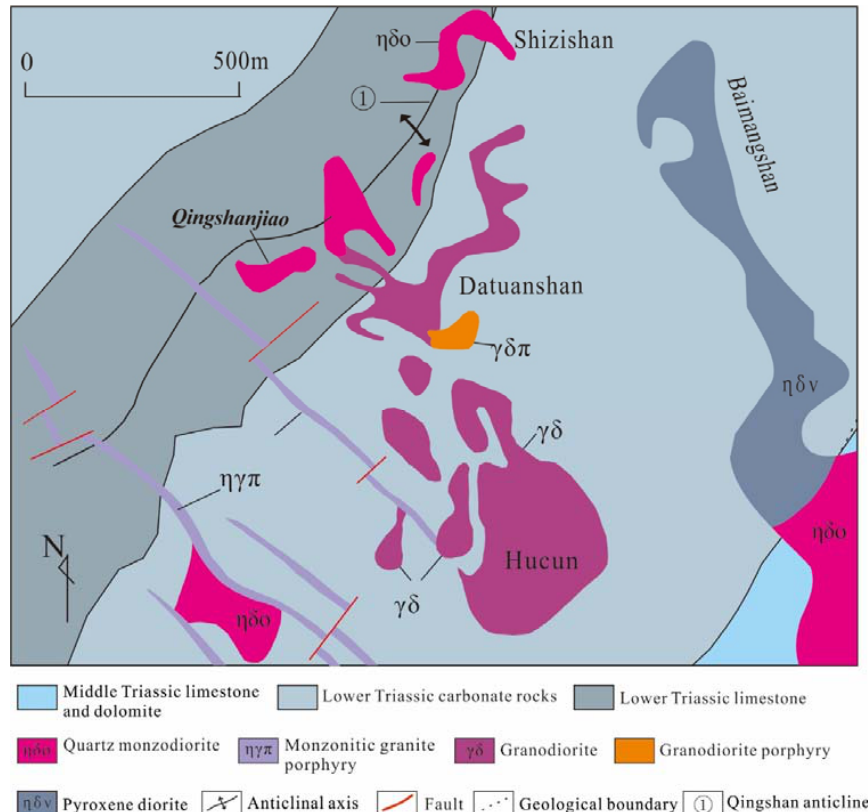
Figure 3. Geological map of the Shizishan ore field [30].